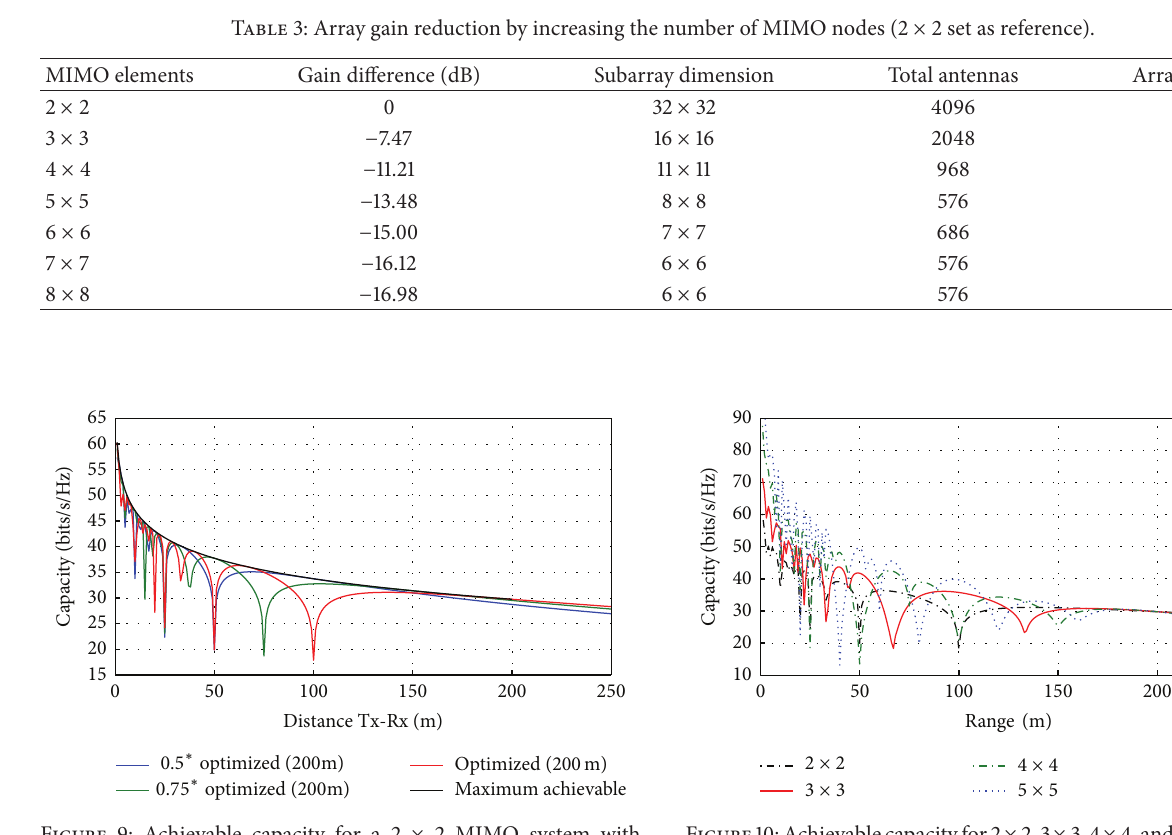
Figure 9: Achievable capacity for a 2 × 2 MIMO system with different element distances.